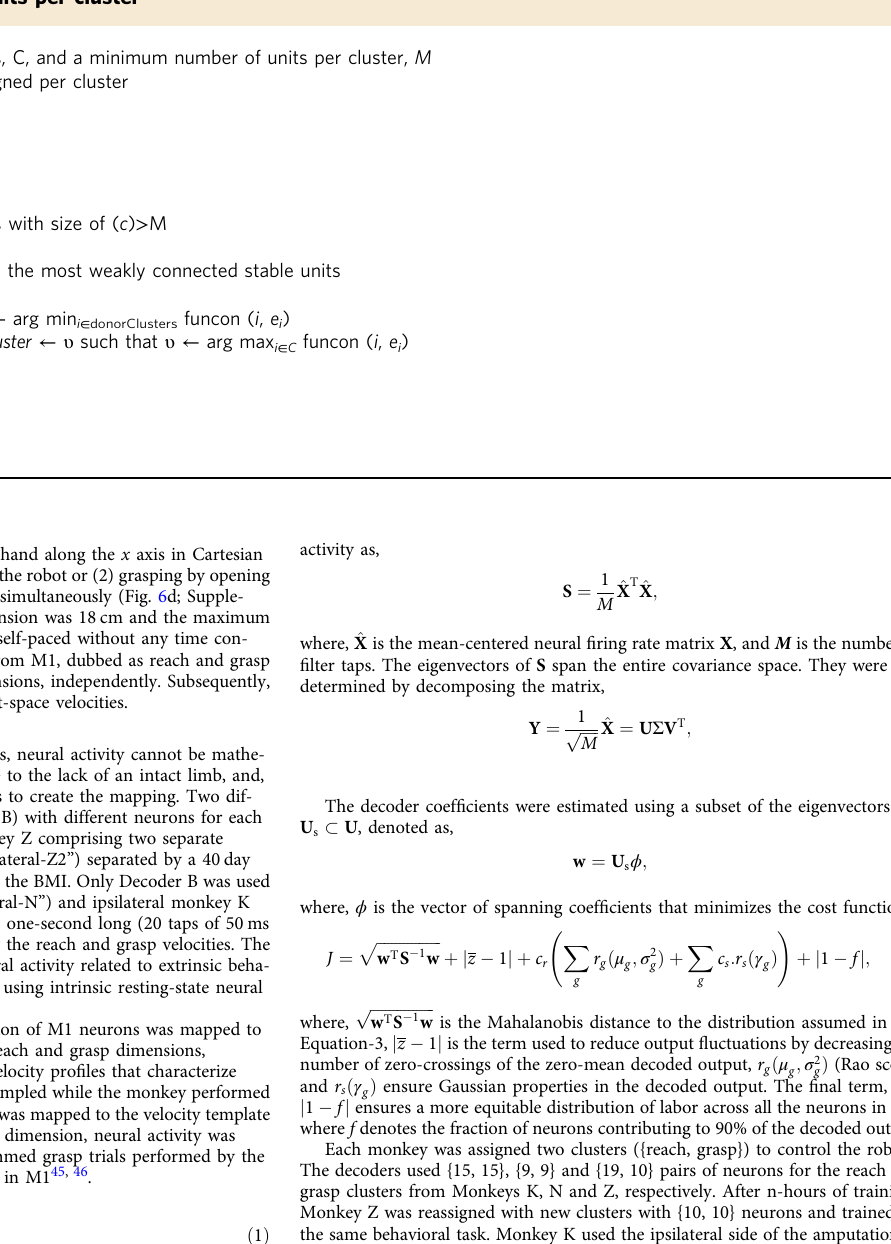
Table 2 Algorithm for balancing units per